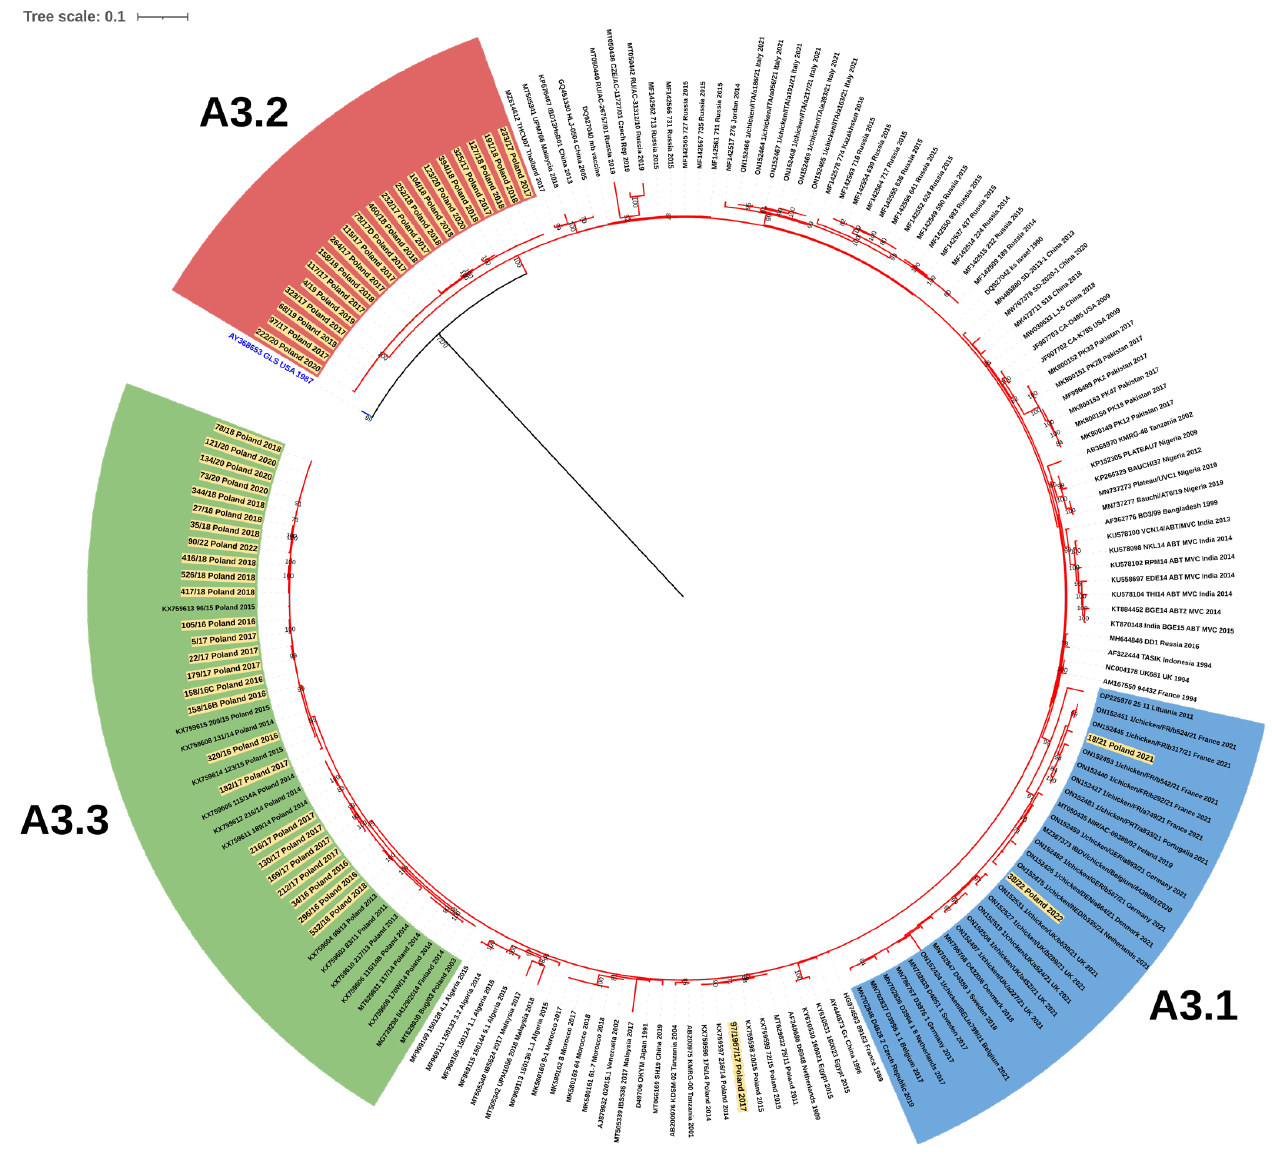
Figure 3. Subtree for the genogroup A3, the clades for the Polish strains were denoted A3.1 in blue, A3.2 in red, and A3.3 in green, and the sequence AY368653 was outgroup (blue).